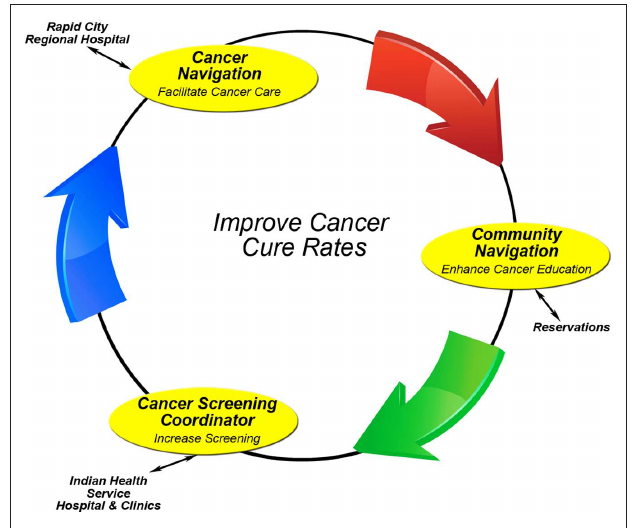
FIguRe 2 | Walking forward comprehensive patient navigation